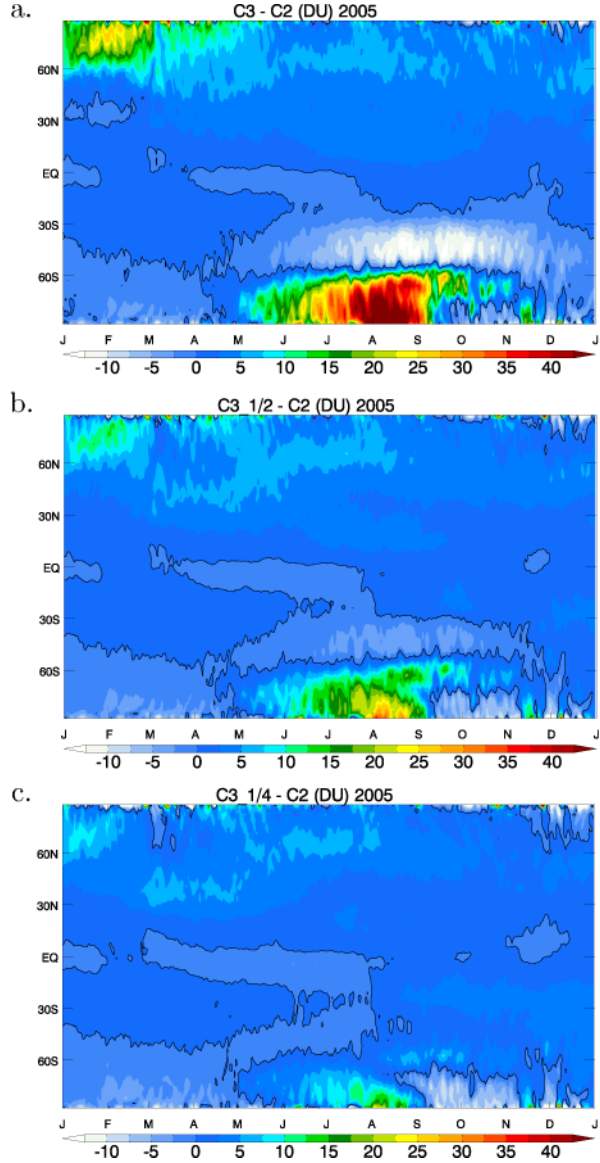
Fig. 5. Convergence of the CTM3 operator-split time step, shown by the difference in daily zonal mean total O 3 column (Dobson Units) between CTM3 runs with different operator-split time steps and CTM2, for the year 2005. (a) C3 (60min) vs. C2 (b) C3 1/2 (30min) vs. C2 and (c) C3 1/4 (15min) vs.